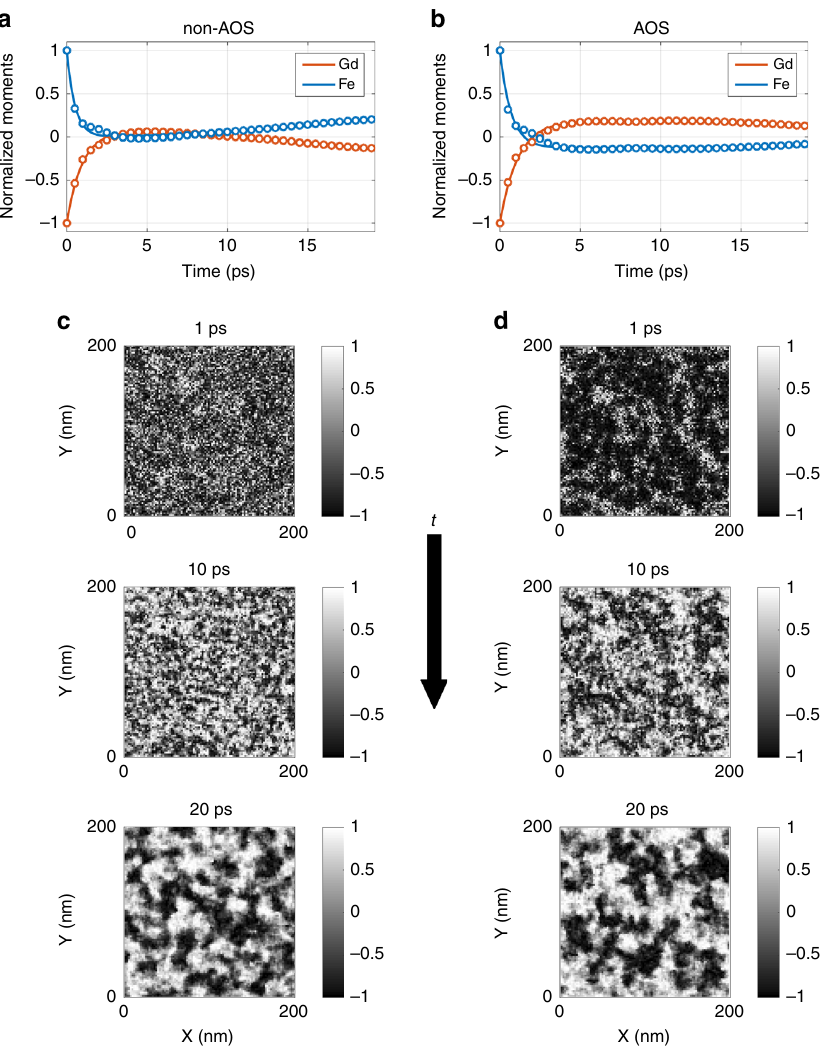
Fig. 4 Simulated magnetisation dynamics. Normalised Gd and Fe average magnetic moments from atomistic simulations in the case of a non-AOS obtained with a fl uence of 10.7 mJ cm − 2 , and b AOS obtained with a fl uence of 11 mJ cm − 2 . Snapshots of the perpendicular-to-plane magnetisation at 1 ps, 10 ps, and 20 ps for the case of c non-AOS and d AOS. In both cases, the magnetisation exhibits coarsening of Fig. 3f, with vertically shifted curves for the sake of clarity. Reliable fi ts were obtained solely by use of a Lorentzian line- shape, shown with the dashed red curves in Fig. 3f.